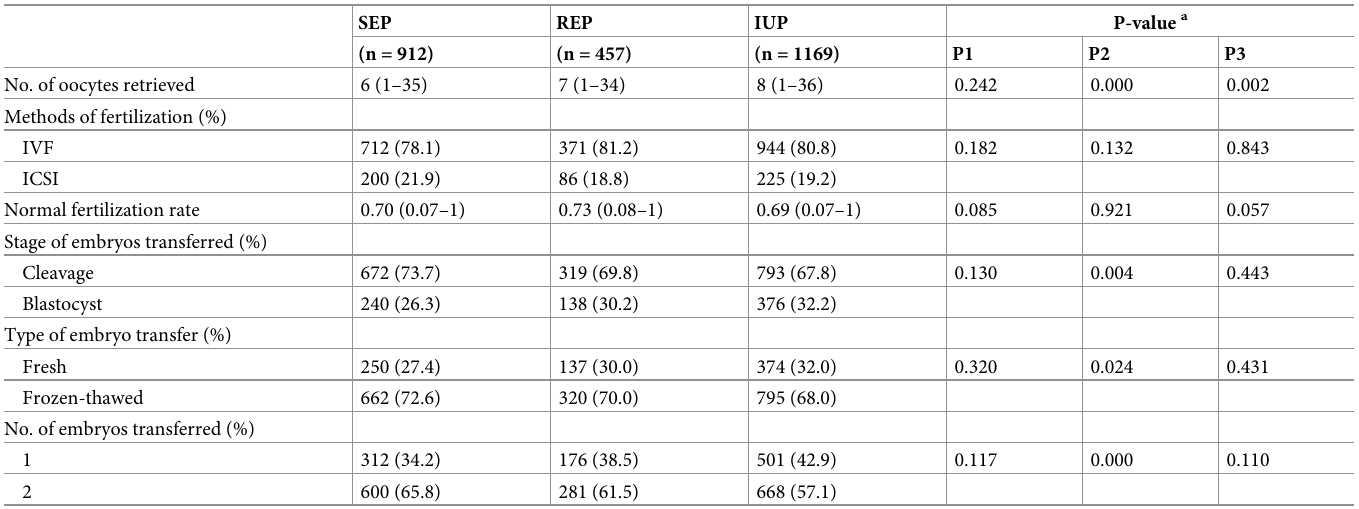
Table 2. IVF/ICSI cycle features in the three